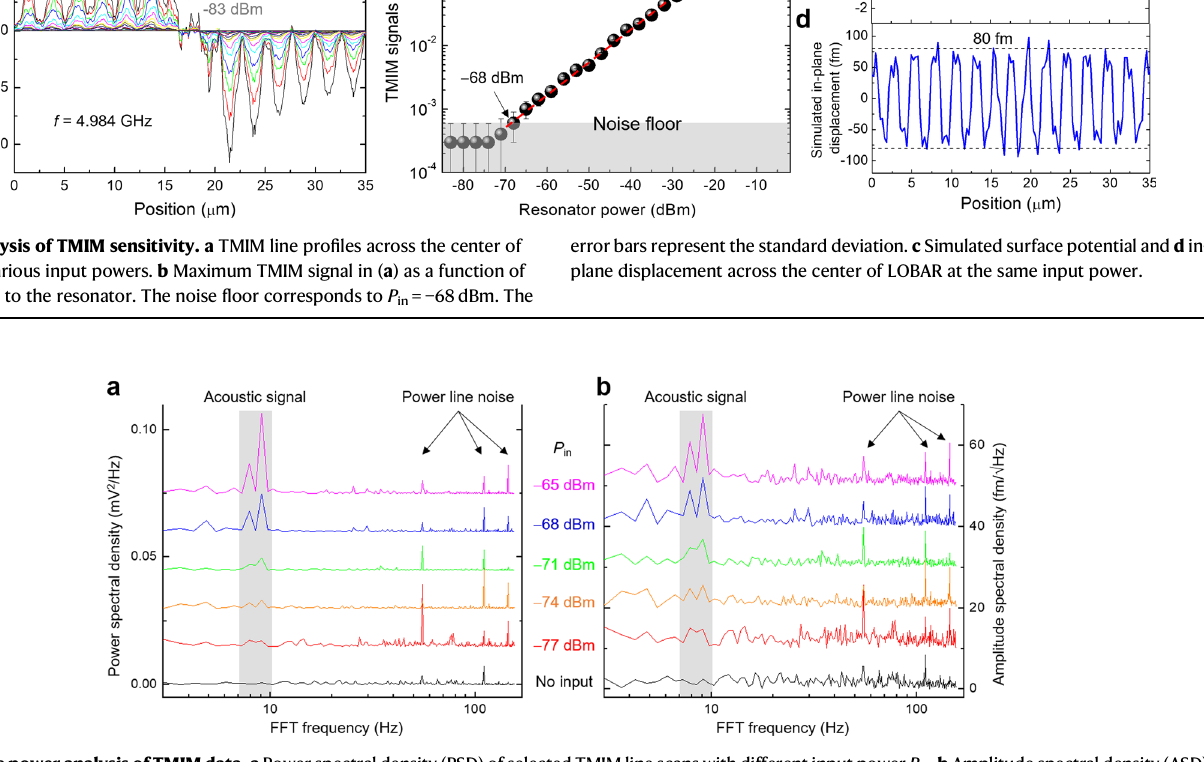
Fig.6|NoisepoweranalysisofTMIMdata.a Powerspectraldensity(PSD)ofselectedTMIMlinescanswithdifferentinputpower P in . b Amplitudespectraldensity(ASD) of the same data in ( a ). Peaks associated with the acoustic signals in this LOBAR device and power-line noise are labeled in both